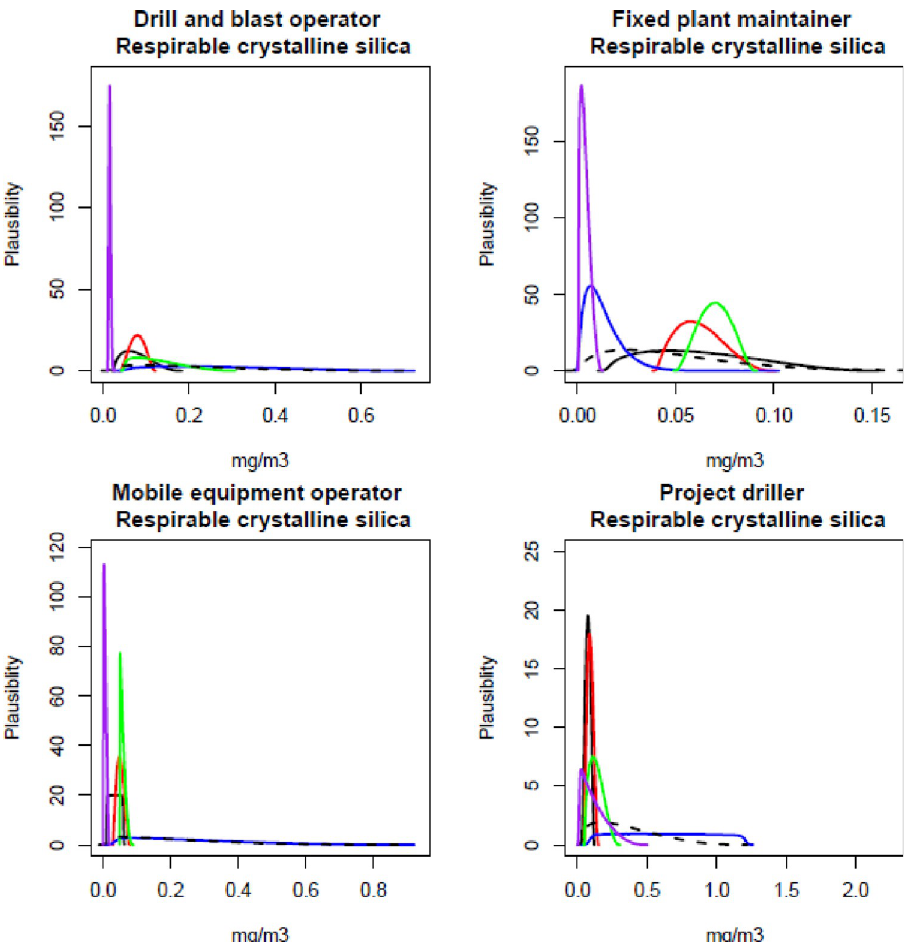
Fig 2. Expert estimates and measured data of respirable crystalline silica concentrations. Each curve depicts the experts support (probability density) or measured data encoded into a scaled Beta distribution. Experts are denoted in the colours blue, red, black and green; combined experts are the dashed line. Measured data is presented as